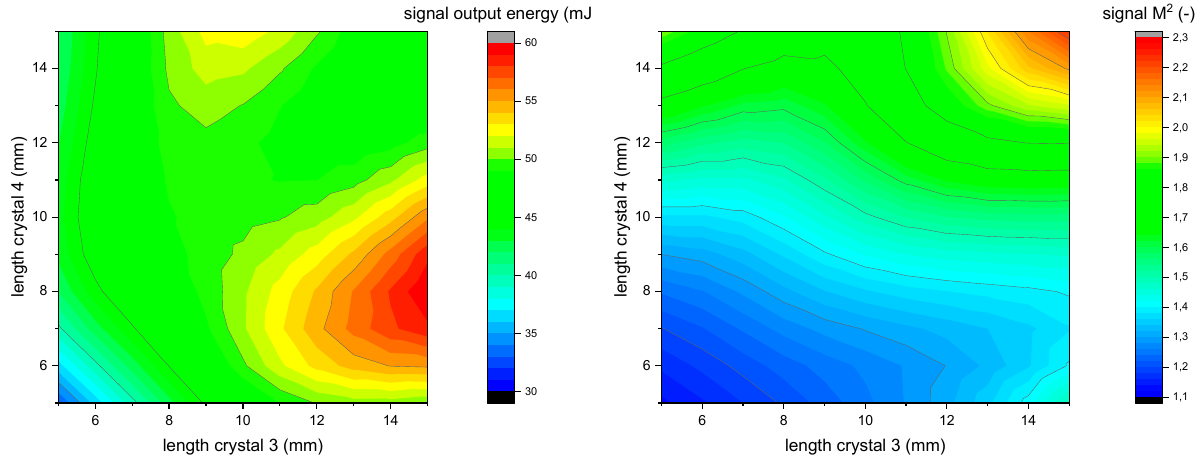
Figure 13. Calculated output pulse energy (left) and beam quality factor (right) after the second OPA stage in dependency of crystal lengths between 5 and 15 mm for an idler seeded OPA. The first stage consists of two 12 mm long crystals and the idler wavelength is coupled out in between all four crystals.